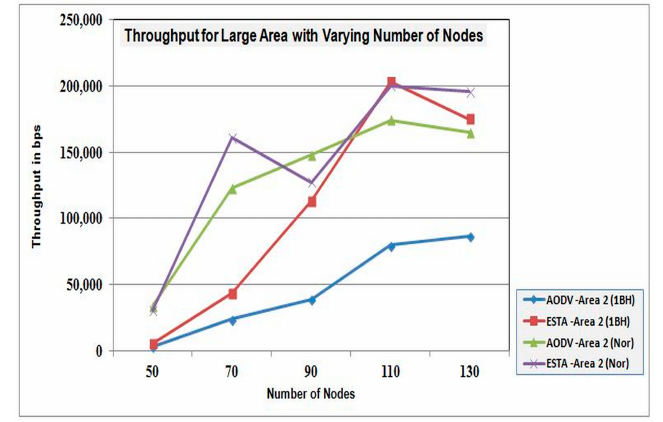
Figure 18. Throughput for varying nodes in a large